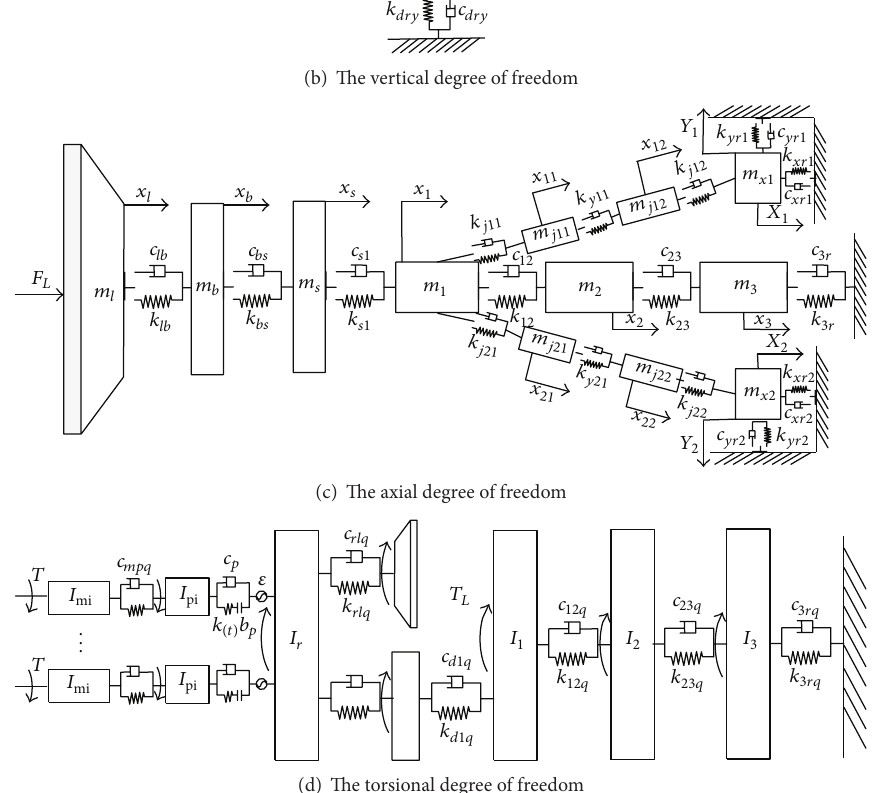
Figure 3: The dynamic model of